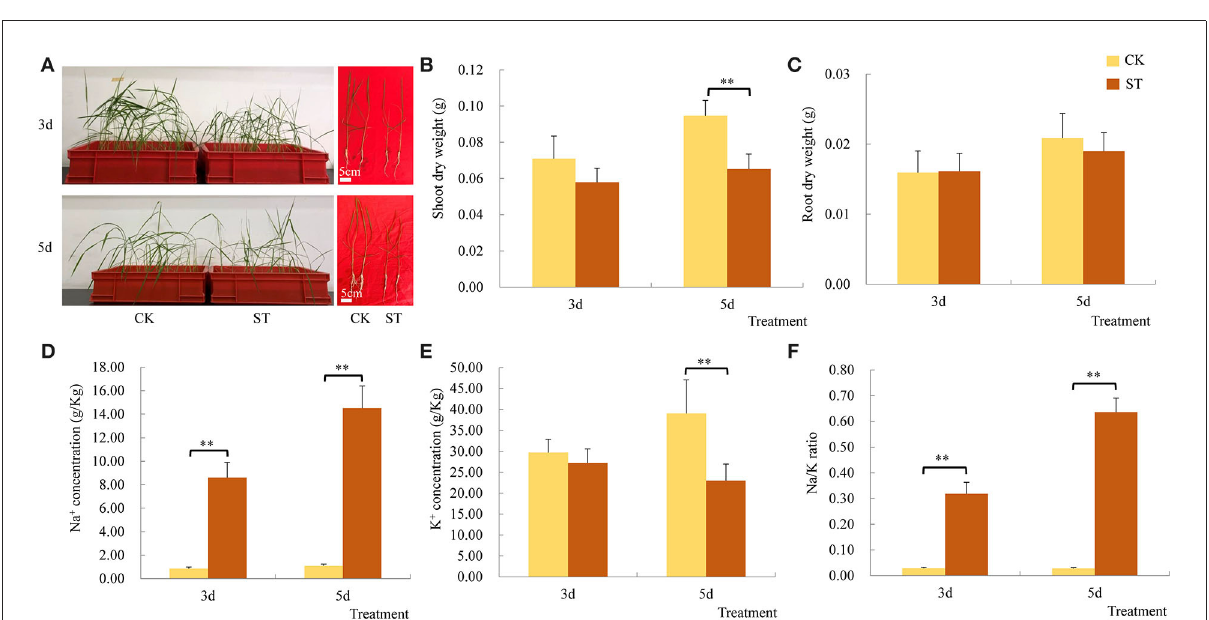
FIGURE1 Effects of salt stress on traits of upland rice landrace 17SM-19. (A) Rice growth. (B) Shoot dry weight. (C) Root dry weight. (D) Na + concentration. (E) Na/K ratio. (F) K + concentration. CK: control; ST: salt treatment. ** P < 0.01.